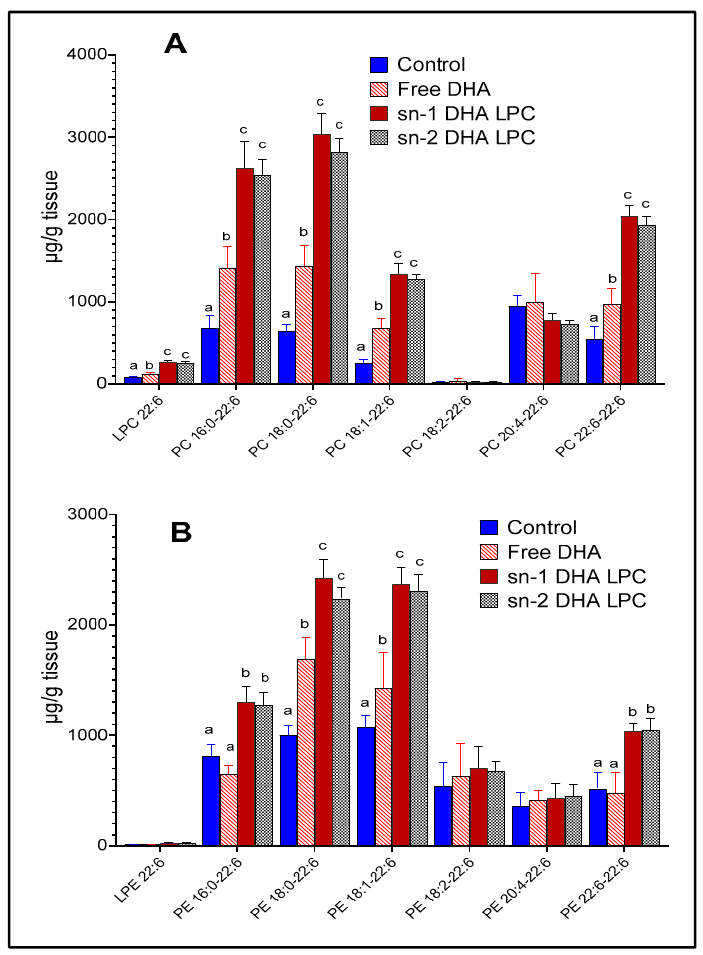
Figure 3. Molecular species of mouse retinal phospholipids containing DHA. The animals were gavaged withfree(unesterified)DHAortwoisomersofLPC-DHAasdescribedunderFigure2. Themolecularspecies of PC ( A ) and PE ( B ) which contain DHA were analyzed using multiple reaction monitoring by LC / MS / MS, as described in the text, using 17:0 LPC, 17:0–17:0 PC, and 17:0–17:0 PE as internal standards. Bars without common superscripts are significantly different from each other by a one-way ANOVA, and Tukey post-hoc analysis (mean ± SD), 6 animals / group). PE: phosphatidylethanolamine; PC: phosphatidylcholine; sn-1 and sn-2: stereospecific numbering 1 and 2 respectively; DHA: docosahexaenoic acid; LC / MS / MS: liquid chromatography / tandem mass spectroscopy; SD: standard deviation; LPC: lysophosphatidylcholine; DHA: docosahexaenoic